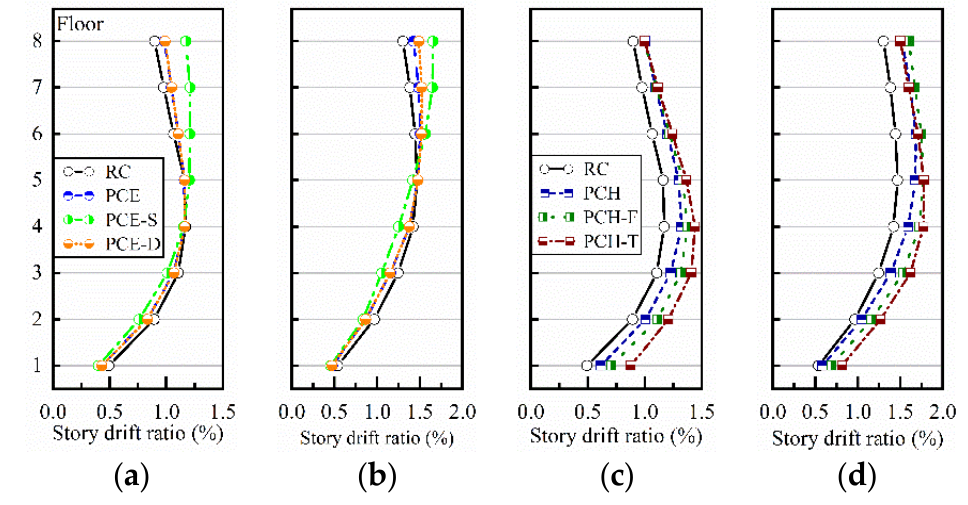
Figure 13. The distribution of maximum floor displacement under rare and extremely rare earthquakes: ( a ) Emulated frames under rare earthquakes; ( b ) Emulated connection frames under extremely rare earthquakes; ( c ) Non-emulated frames under rare earthquakes; ( d ) Non-emulated frames under extremely rare earthquakes.